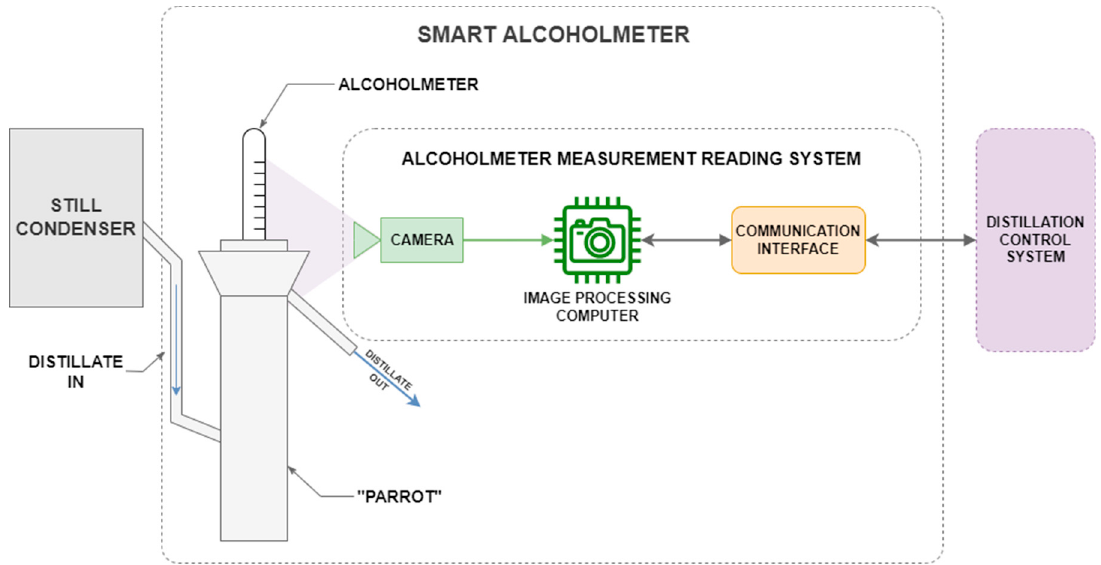
Figure 4. System diagram of complete alcohol concentration measurement system. It consists of parrot with alcoholmeter to measure alcohol concentration and alcoholmeter measurement reading system to digitalize measurement in real-time and supply it to distillation control or supervision system.